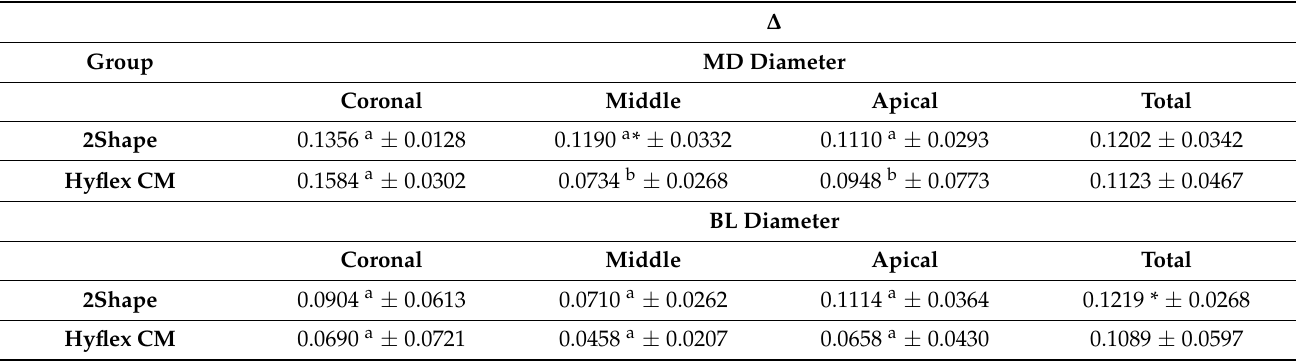
Table 2. Mean and standard deviation (SD) of change ( ∆ ) in maximum mesiodistal and buccolingual dimensions considering each anatomical level and total root canal space.